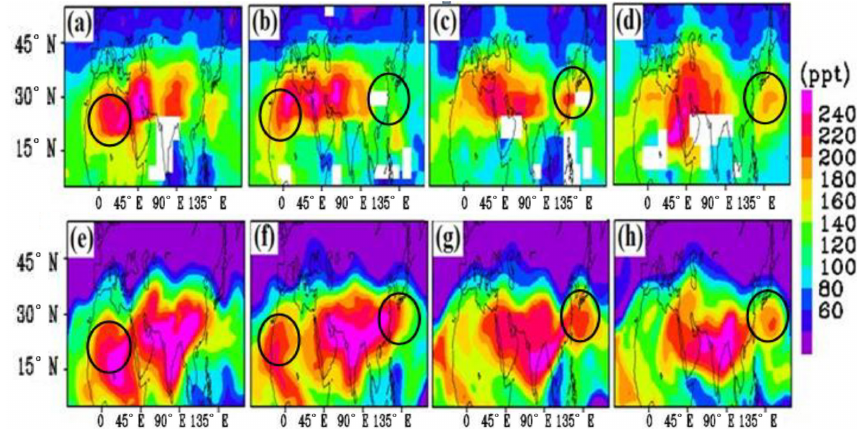
Figure 6. Spatial distribution of PAN mixing ratios (ppt) at 16km: MIPAS satellite observations for (a) 1–2 July, (b) 3–4 July, (c) 5–6 July and (d) 7–8 July 2003, and ECHAM5-HAMMOZ CTRL simulations for (e) 2 July, (f) 4 July, (g) 6 July and (h) 8 July 2003. Maximum amounts of PAN near the location of eddies are shown with black circles.